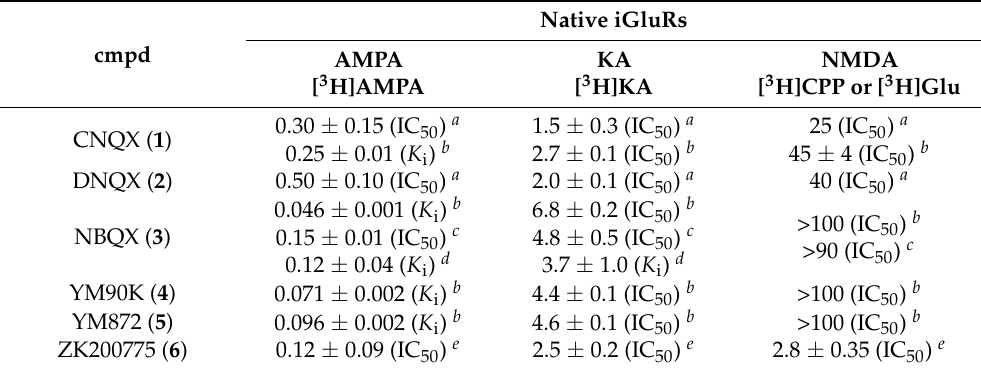
Figure 3. Structures of selected KAR antagonists based on the quinoxaline-2,3-dione structure. Table 1. Receptor binding affinity of early quinoxaline-2,3-diones at native iGluRs, determined in radioligand binding assays (all values in µ